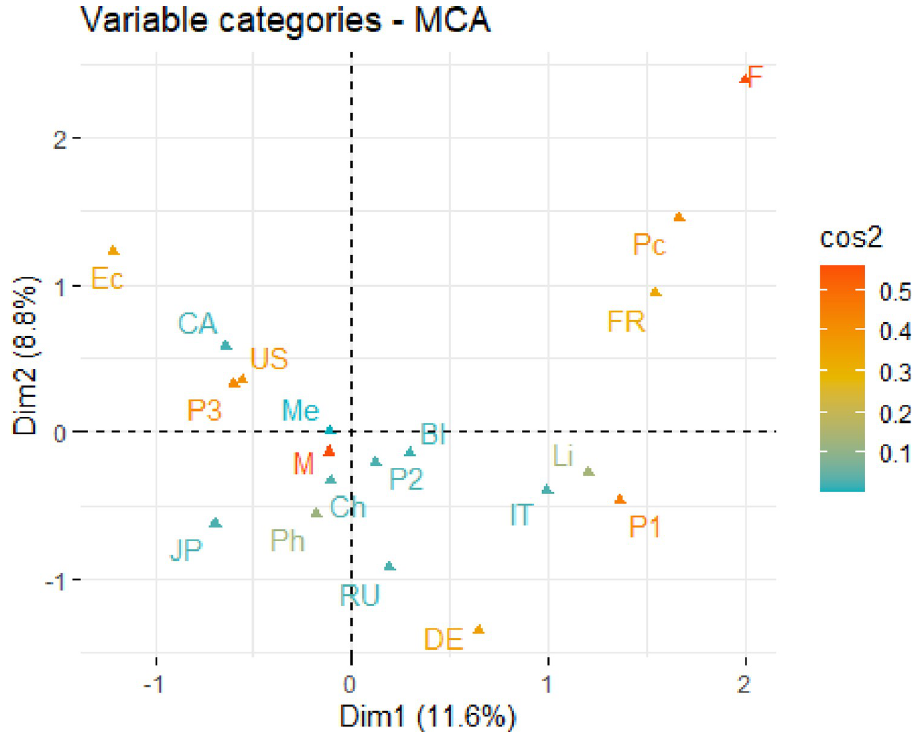
Fig 1. Two-dimensional correspondence plot using